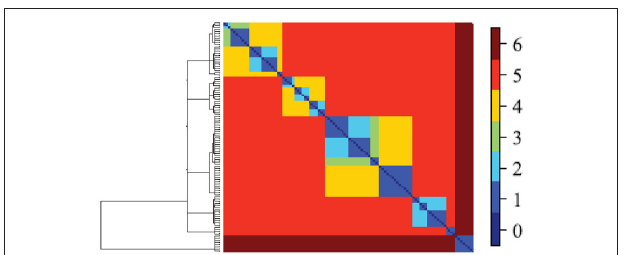
FIGURE 4 | Illustrative DCG-tree based on fMRI data (Fushing et al., 2013). Tree on left panel also corresponds to pattern on top panel. Note that different levels of the tree (known as “temperature”) yield different blocking patterns corresponding to communities. At the highest temperature indicated in dark red, a single community is observed; at the lowest temperature, 19 communities are observed. DCG finds the best clustering solutions at multiple levels in the tree.